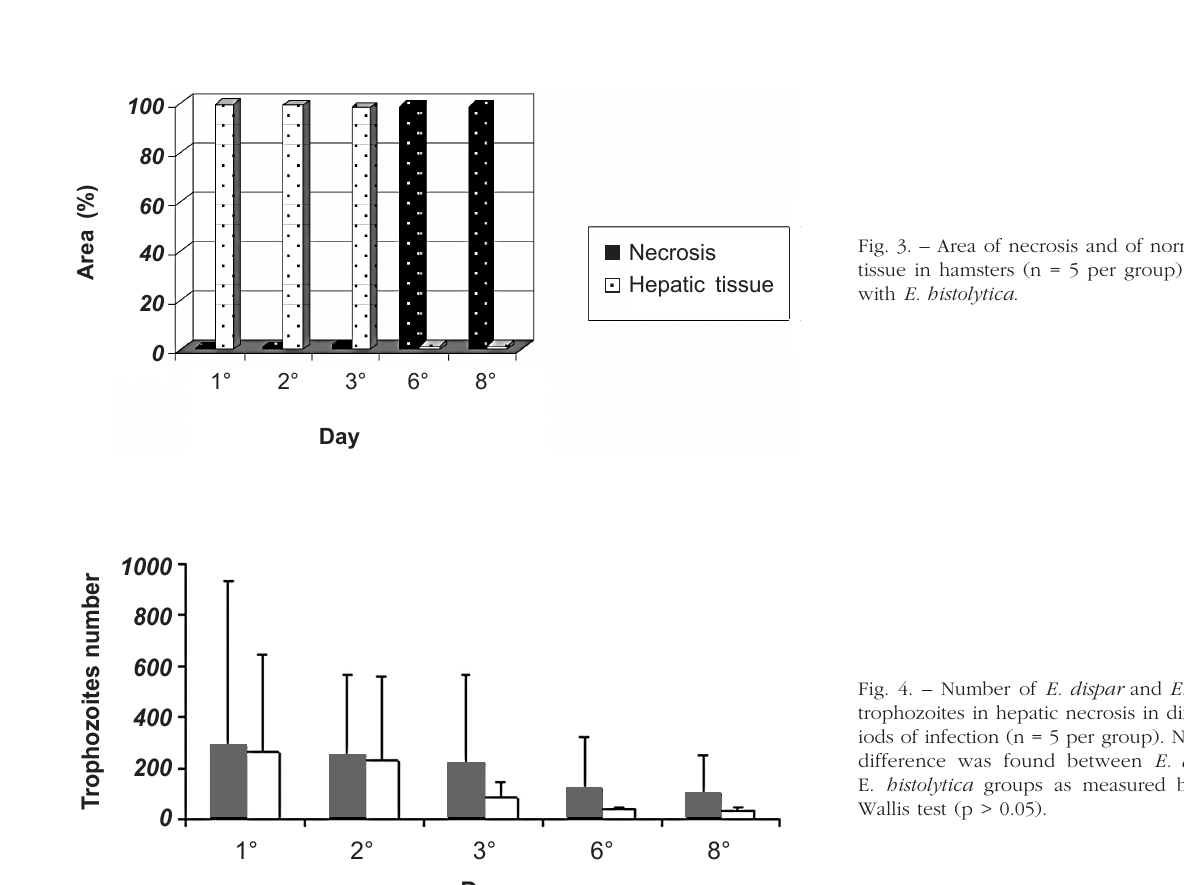
Fig. 2. – Area of necrosis and of normal hepatic tissue in hamsters (n = 5 per group) inoculated with E. dispar .